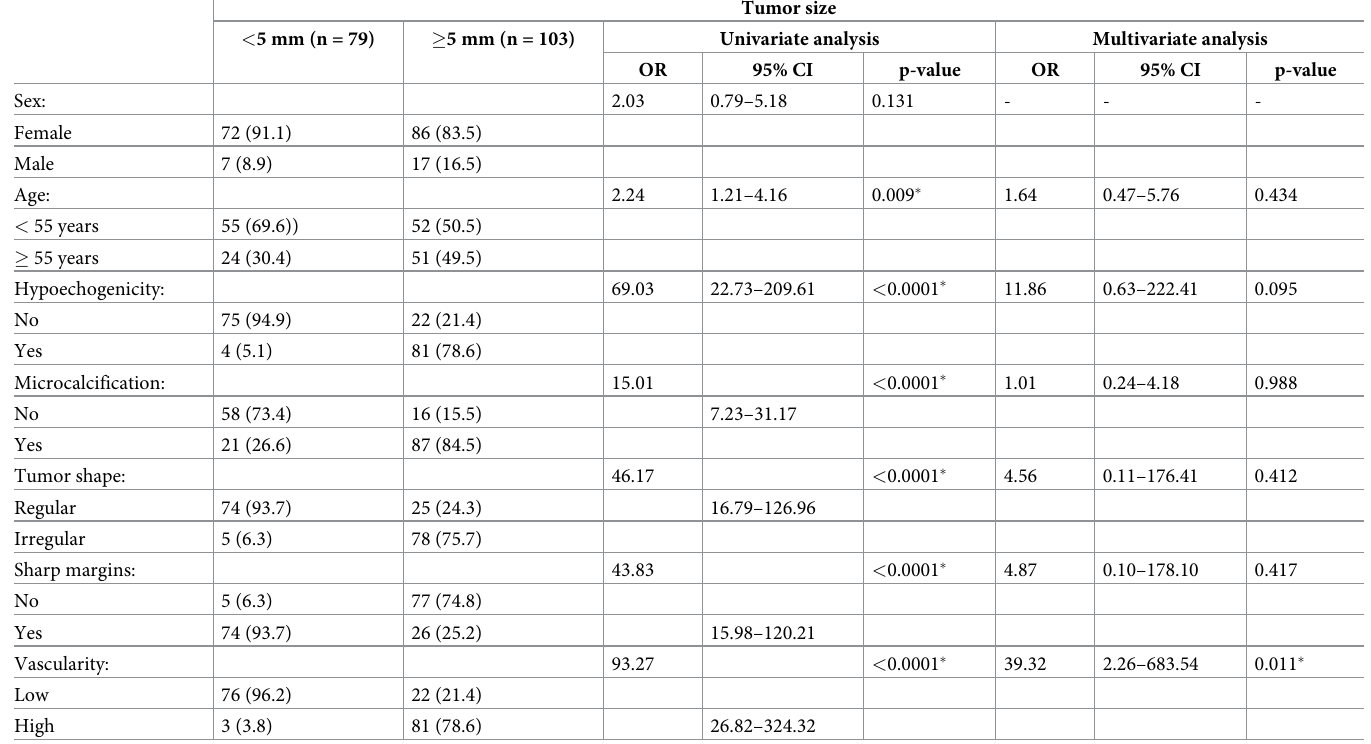
Table 5. Univariate and multivariate logistic regression analyses of demographic and ultrasound features as risk factors for tumors equal to or greater than 5 mm in diameter in PTMC